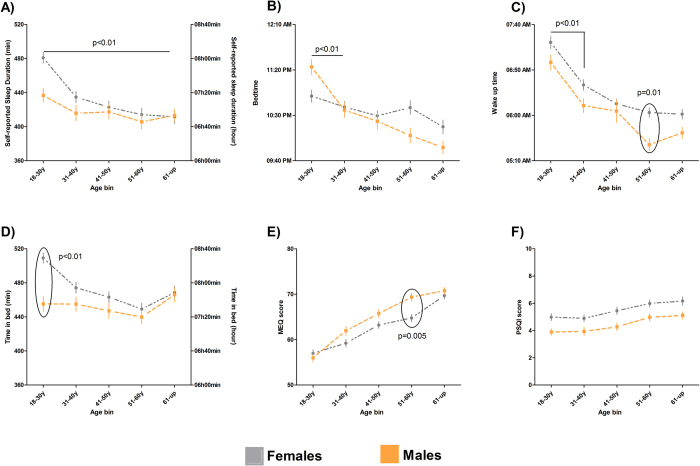
Age and sex influence sleep characteristics and chronotype.Values are presented as means ± standard error (A) Self-reported sleep duration. Bonferroni post hoc test indicated a difference between means of sleep duration at the youngest (18–30y) and the oldest age bins (61-up) for both sexes. (B) Self-reported bedtime. Bonferroni post hoc test suggested a significant advance in bedtime of men from the age bin 18–30y to the 31–40y when women presented later bedtimes. (C) Self-reported wake-up time, Bonferroni post hoc test found significant differences between the youngest (18–30 years) to the second youngest (31–40 years) bins in both sexes, with significant sex differences emerging for the age bin 51–60 years. (D) Time in bed. Bonferroni post hoc test indicated a significant difference between sexes for the youngest age bin (18–30 years). (E) MEQ score, Bonferroni post-hoc testing yielded a statistically significant difference between sexes in the age bin 51–60y, when men reported more morningness. (F) PSQI score, no interaction was found, women presented increasingly poor sleep quality after 41–50 years in comparison to youngest age bin (18–30 years).